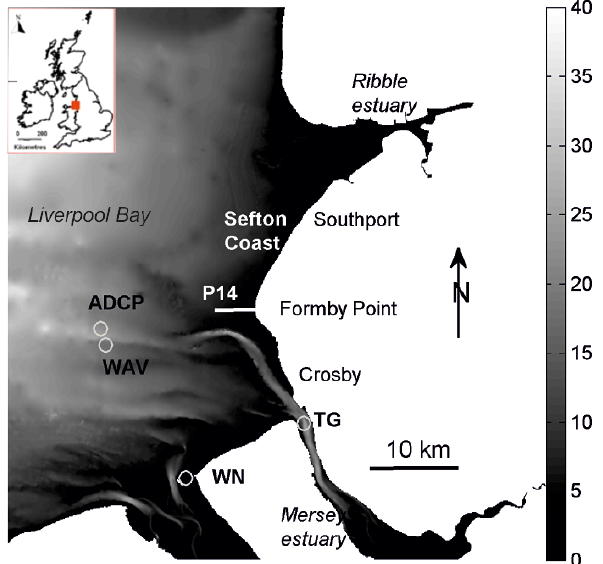
Figure 1. Liverpool Bay with the locations of the studied Formby Point transect P14, on the Sefton coast, and points of used obser- vations; WAV (offshore wave characteristics), TG (Liverpool Glad- stone Dock, nearshore tide) and WN (Hilbre wind